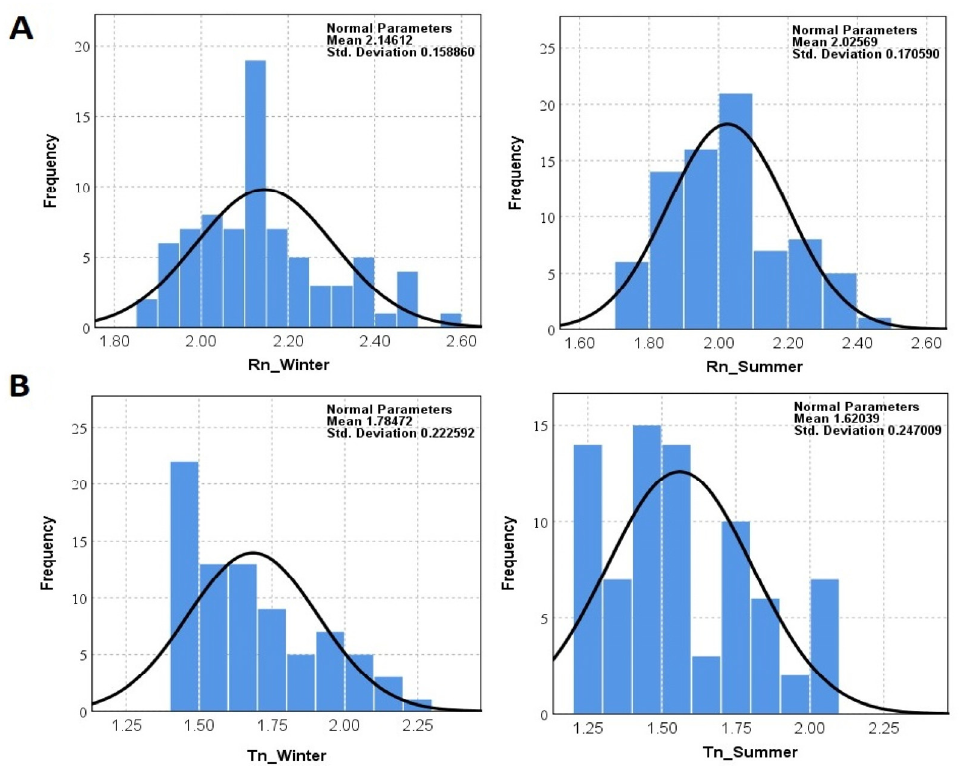
3 Figure 3. Log-Normal Distribution of indoor ( A ) radon and ( B ) thoron concentrations (Bq m − 3 ) over the two seasons at the ground level of dwellings examined in